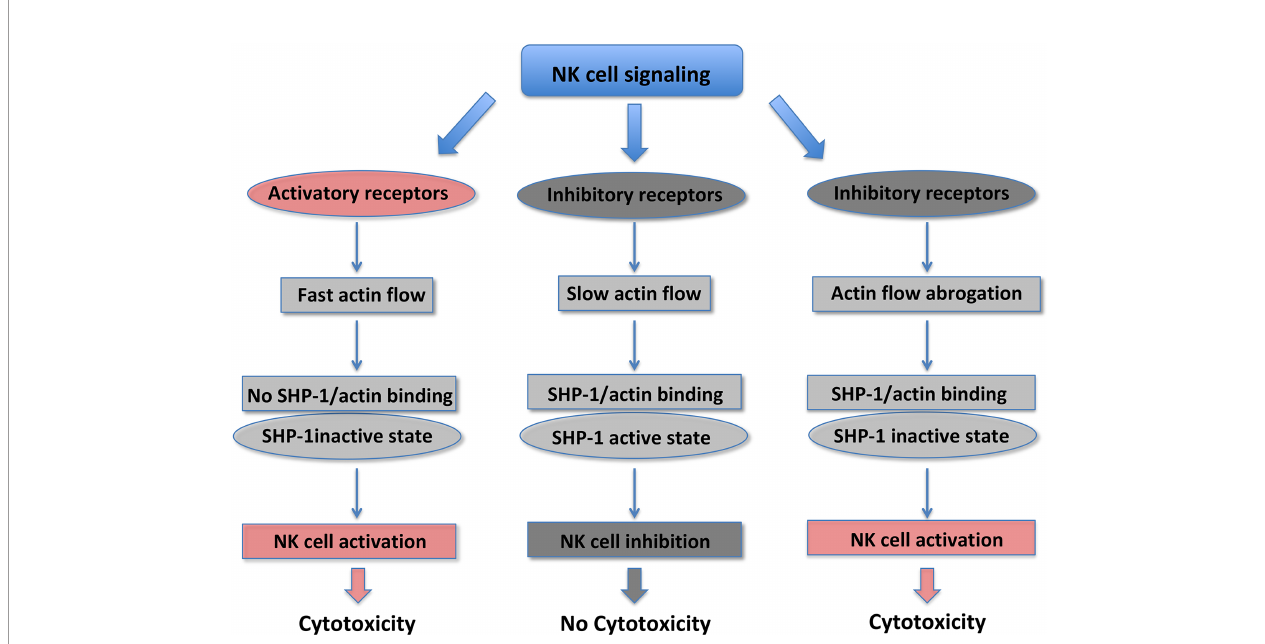
FIGURE 1 | NK cell cytotoxicity is regulated by changes in SHP-1 conformational